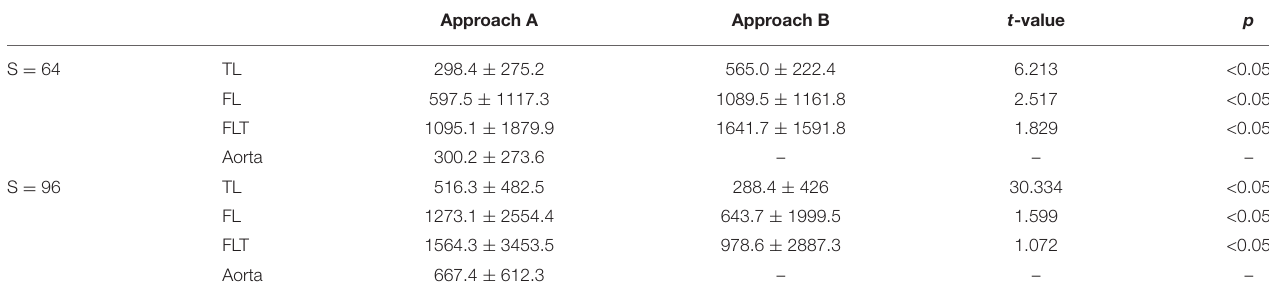
TABLE 3 | Mean and standard deviation of Hausdorff distance of baseline method, and t -test value between the Approach A and Approach B for four substructures segmentation in